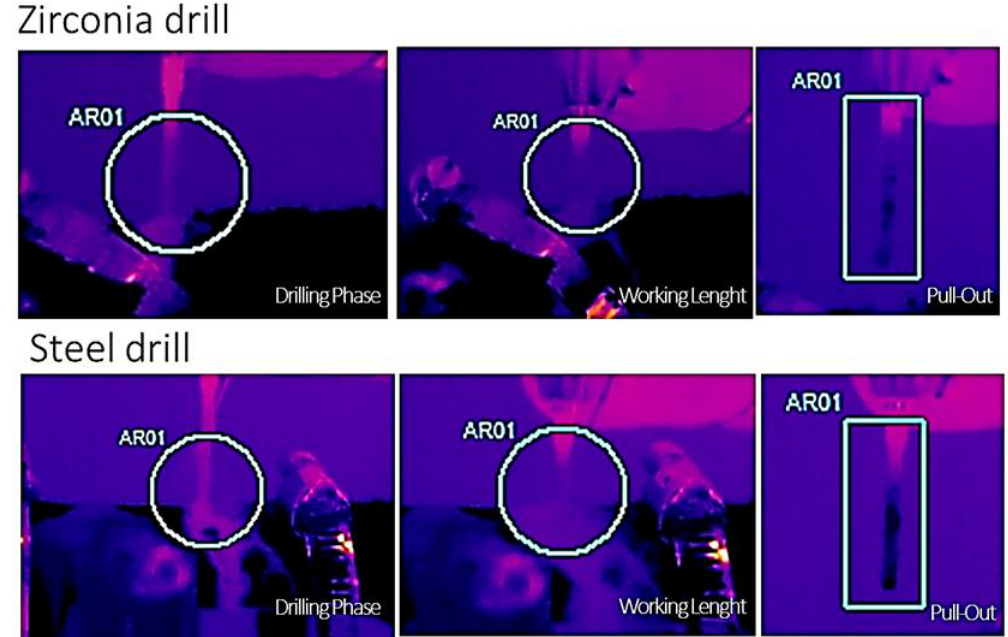
Figure 5. Real-time infrared thermography of the zirconia drill (Group 8) and stainless steel (Group 4). A detail of the temperature variations during the drilling phase, at working length and at drill